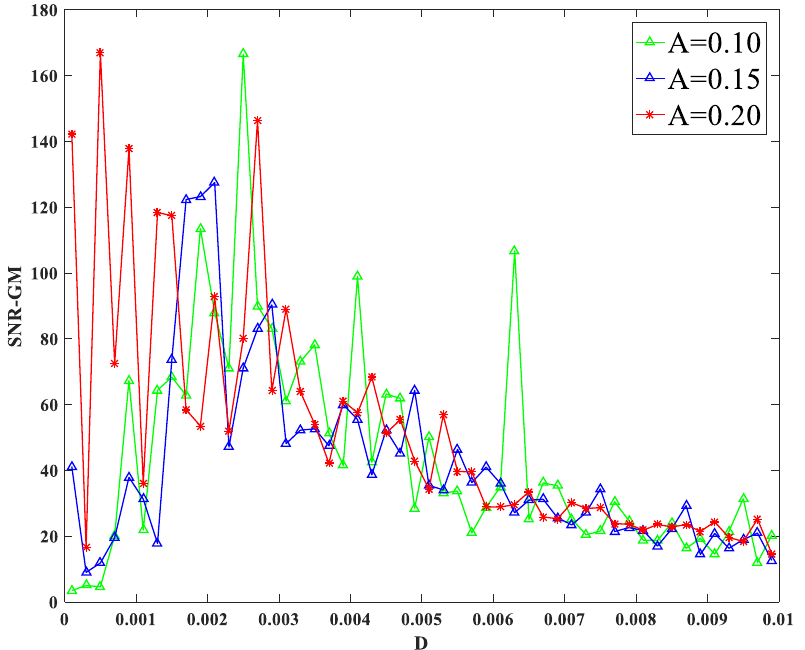
Figure 8. SNR-GM for different values of A .